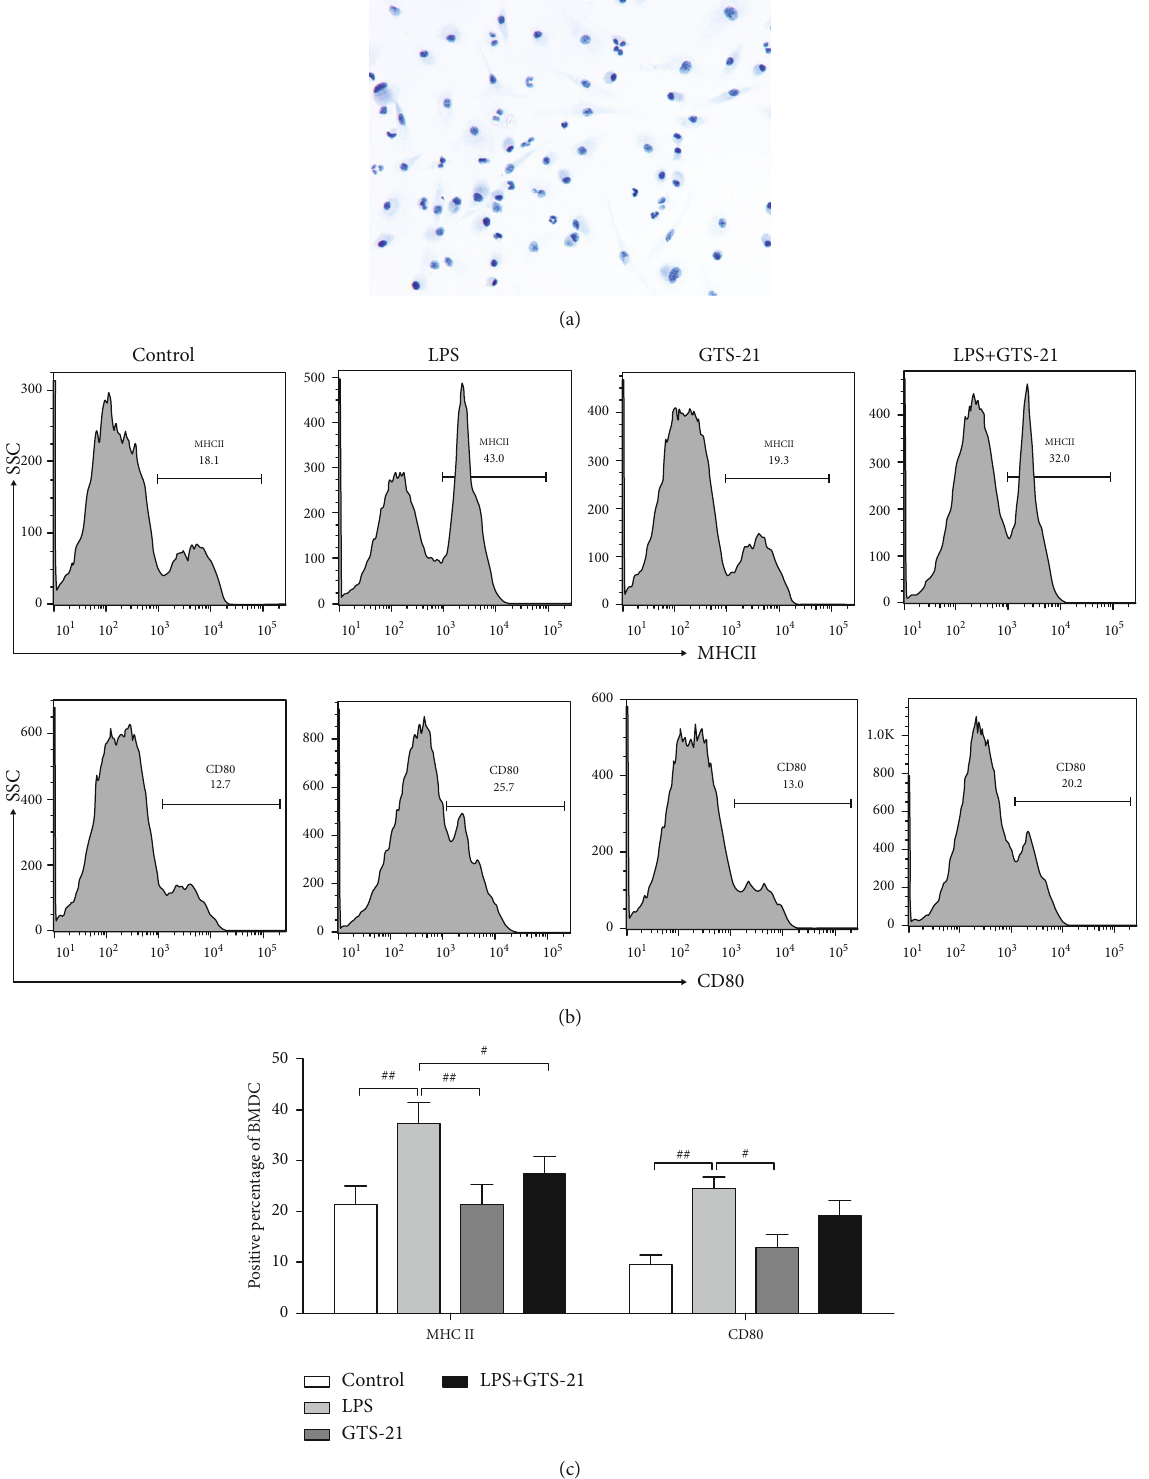
Figure 4: GTS-21 treatment weakened the mature di ff erentiation of DCs in vitro . (a) The morphology of BMDCs on days 7 of culture (400x magni fi cation). (b, c) Flow cytometry analysis was used to examine the percentages of MHCII- and CD80-positive expression on the surface of CD11c + F4/80 - BMDCs. All data are shown as mean ± SD ( n = 4 – 6 mice/group). # p < 0 : 05 , ## p < 0 : 01 , ### p < 0 : 001